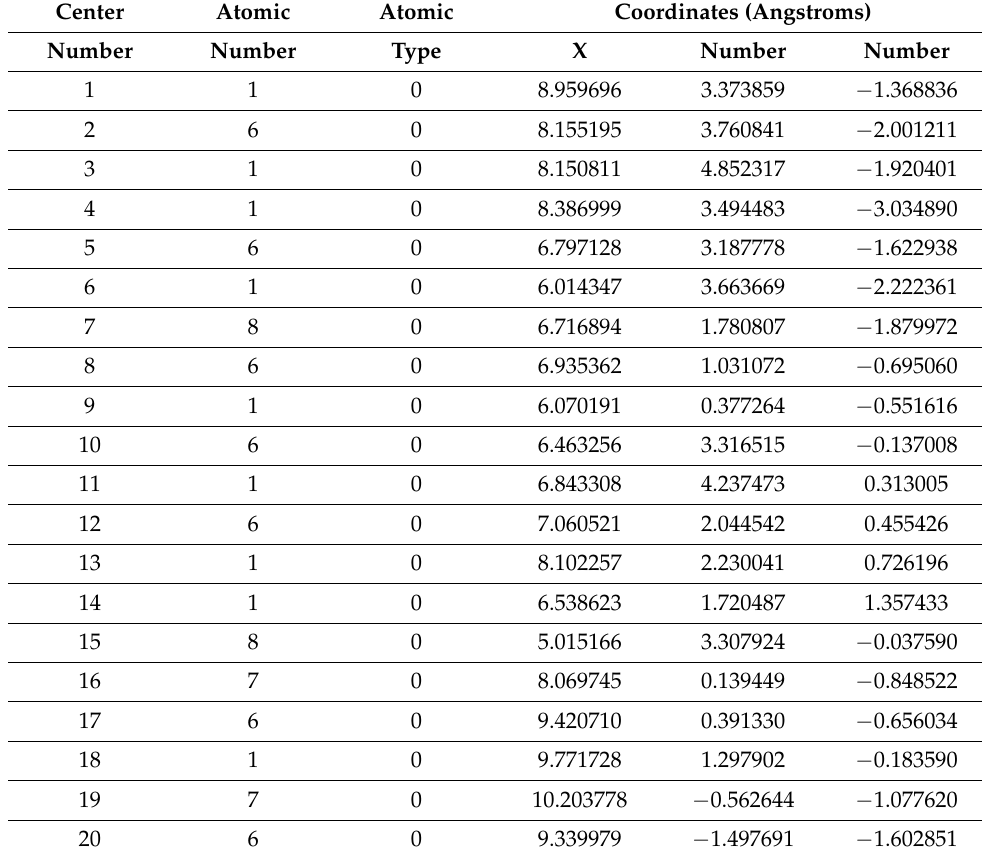
Table A15. Complex MgI 3 LiII 2 with nucleotide triplet